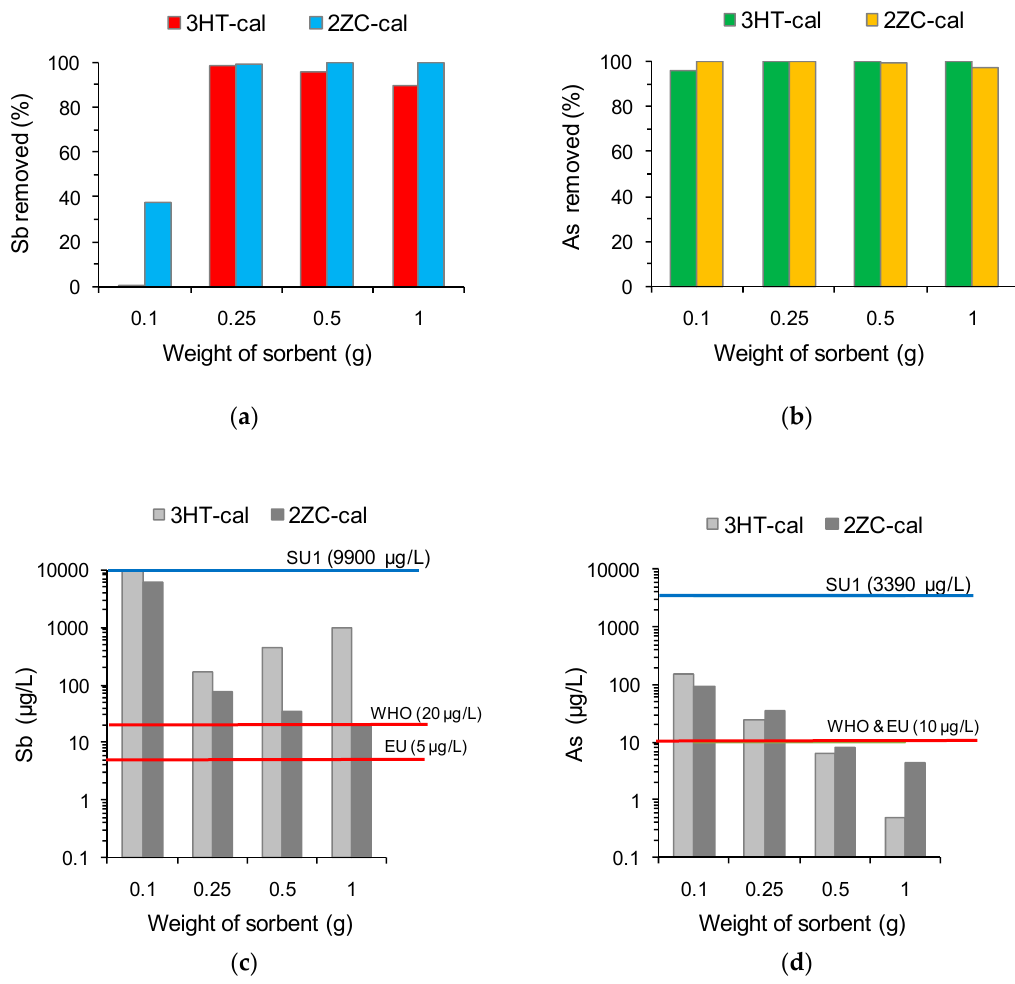
Figure 4. Results of batch sorption experiments performed with 3HT-cal and 2ZC-cal with the Su Suergiu mine drainage (SU1). Percentages of ( a ) Sb and ( b ) As removed at the end of the sorption experiments, and concentrations of residual ( c ) Sb and ( d ) As in solution at the end of the experiments for different amounts of the sorbent. In the plots ( c ) and ( d ) the blue lines indicate the starting Sb or As concentrations; the red lines indicate the limits of Sb and As set for drinking water by the World Health Organization (WHO) [2] and the European Community (EU) [3].